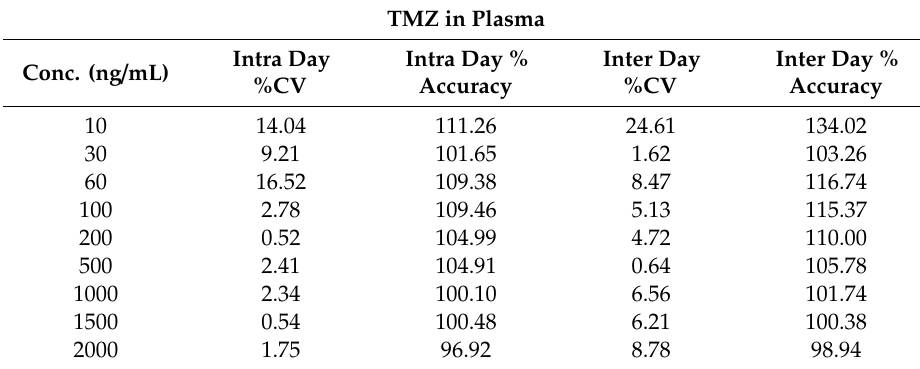
Figure 4. ( a , b ) Extracted ion chromatogram (XIC) of TMZ with and without caffeine 30:70 (Water 0.1% FA: ACN 0.1% FA) in the plasma sample. ( c ) The simultaneous injection and separation XIC of TMZ and caffeine (caff). Table 1. Percentage of CV and percentage of accuracy of the quantitation of TMZ in intraday and inter-day runs for plasma.